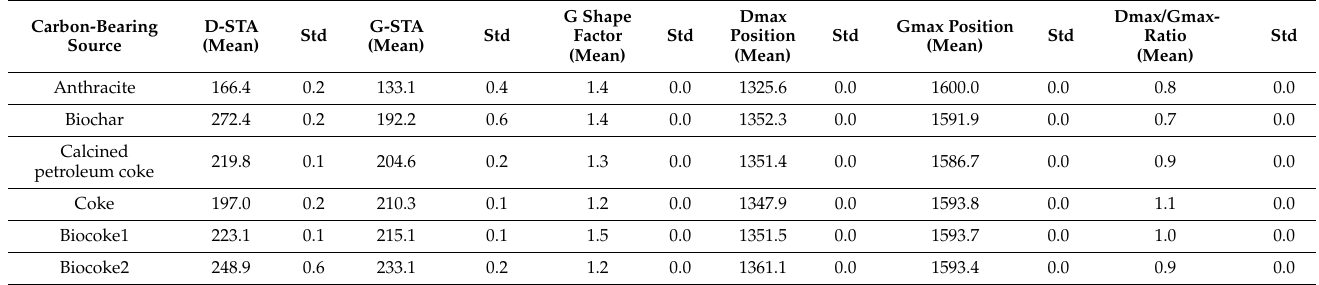
Table 7. Raman spectral parameters (see [50]) (median of 10 spot measurements) for the carbon- bearing sources.